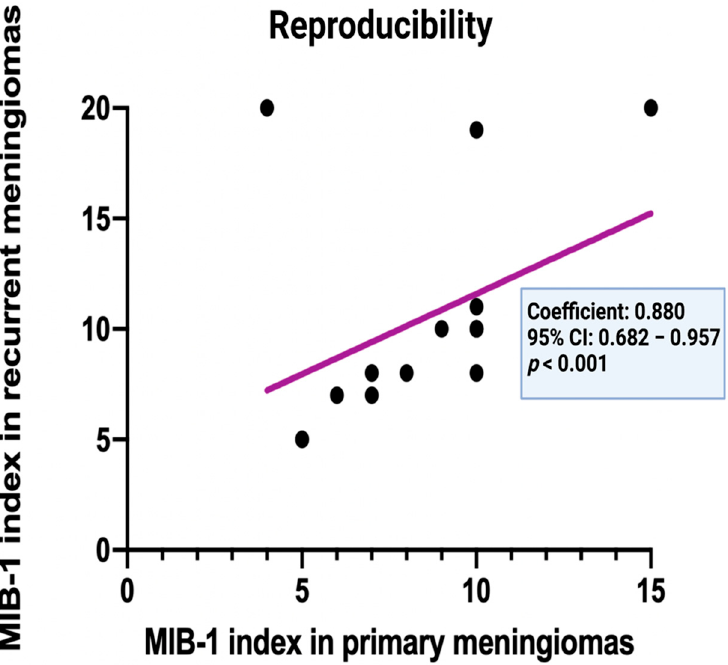
Figure 6. Corresponding MIB − 1 index ( n = 16) of primary and recurrent cranial meningiomas.